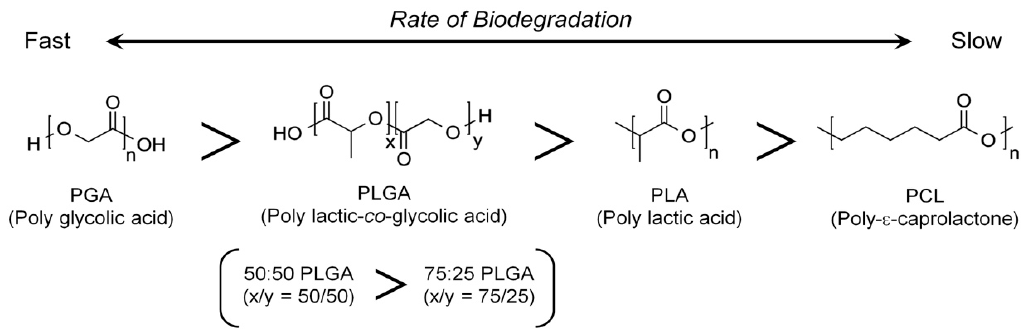
Figure2. Syntheticbiodegradablepolymersandtherelativehydrolyticdegradationratesofbiopolymers. Figure 2. Synthetic biodegradable polymers and the relative hydrolytic degradation rates of PGA hydrolysis is the fastest and PCL is the slowest. biopolymers. PGA hydrolysis is the fastest and PCL is the slowest.